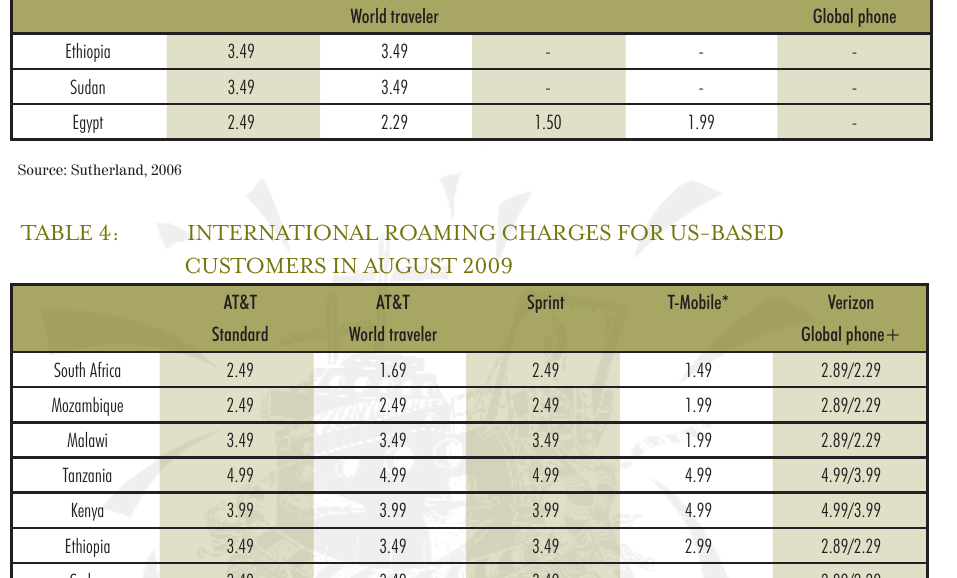
INTERNATIONAL ROAMING CHARGES FOR US-BASED CUSTOMERS IN AUGUST